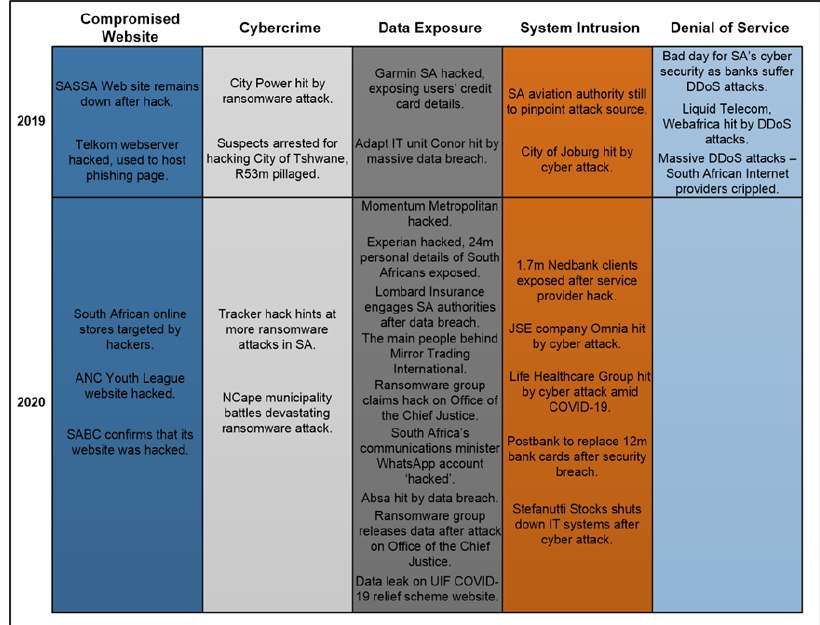
Figure 4: Classification of cyber incidents by type, 2019 – 2020 (30